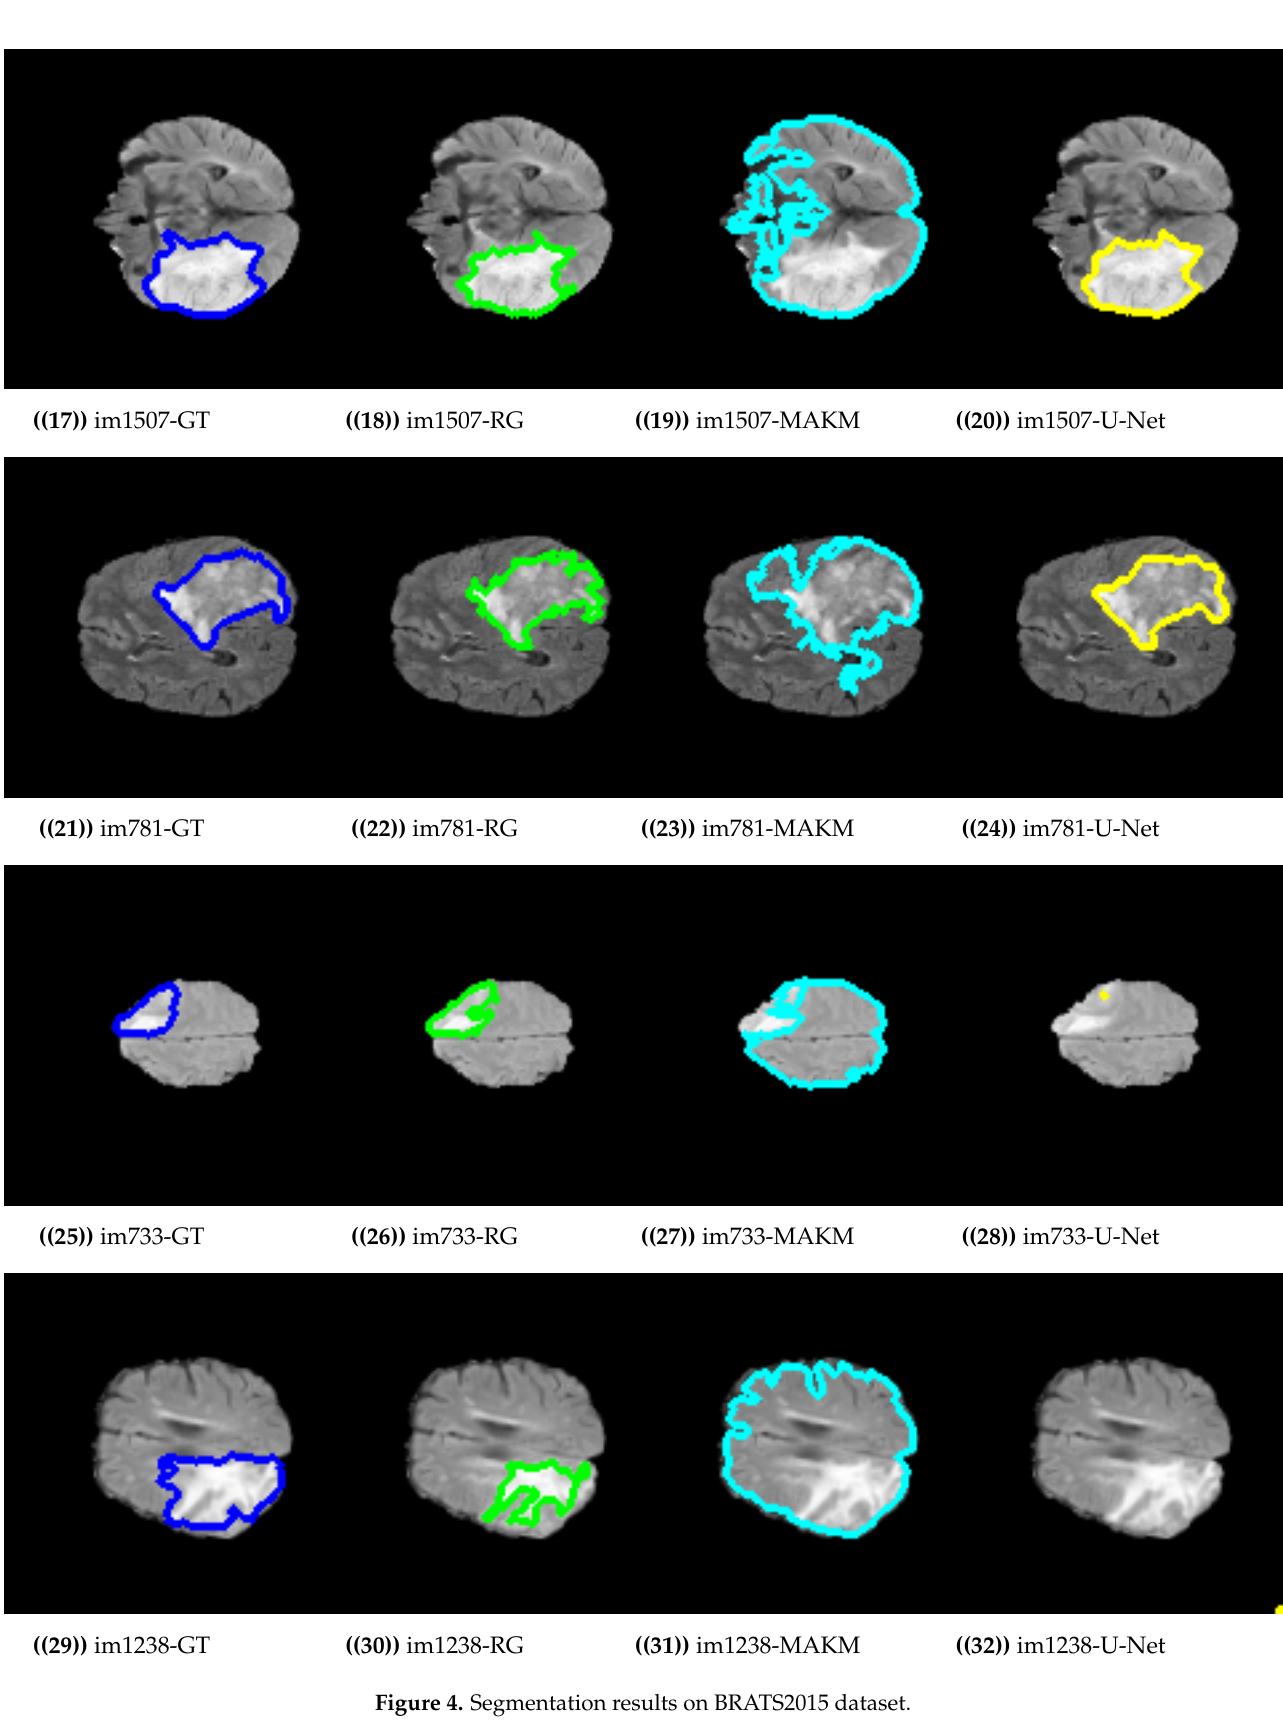
Figure 4. Segmentation results on BRATS2015 dataset